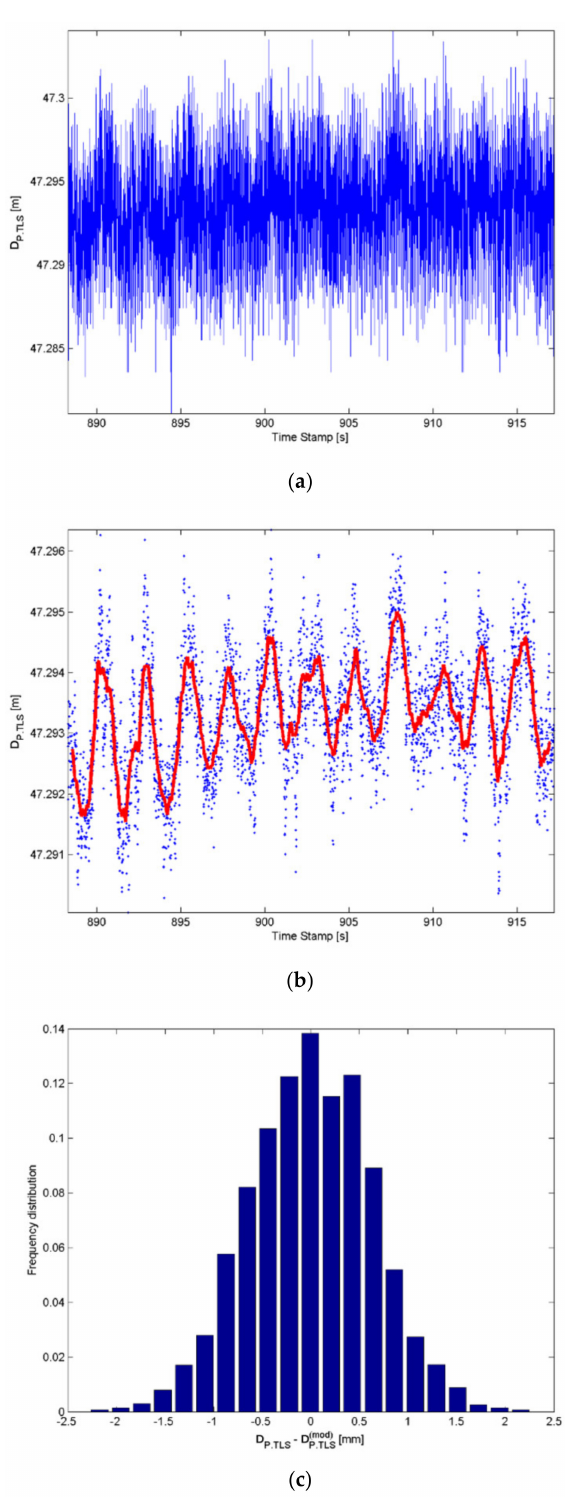
Figure 8. ( a ) Distance DP,TLS of point P on the wind tower located at H = 65 m during acquisition in operating condition c (see Table 3); ( b ) result after applying the proposed methodology; ( c ) frequency distribution of di ff erences between modelled DP,TLS distances (blue dots) and moving average (red line). The standard di ff erence between measured and model DP,TLS distances is 0.6